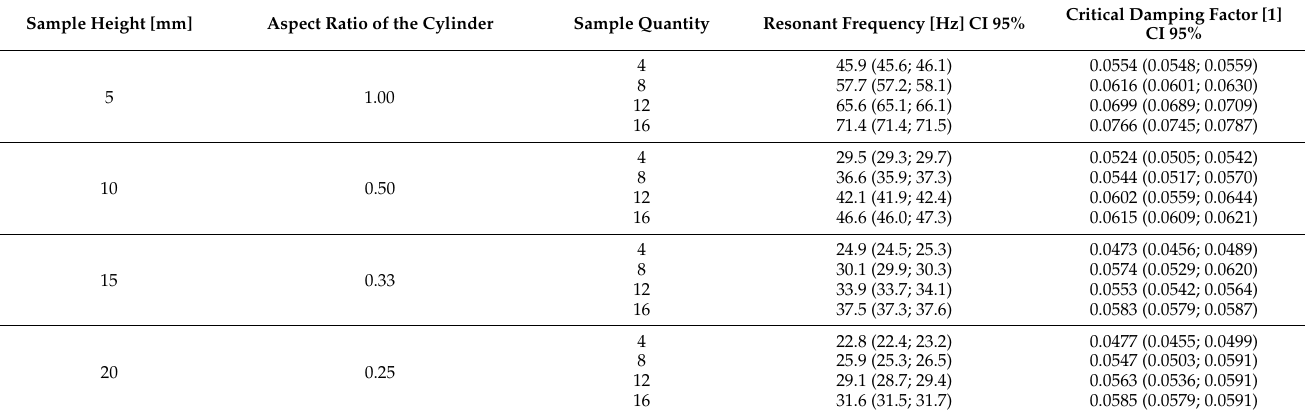
Table 5. Results of measurements using the frequency response spectrum